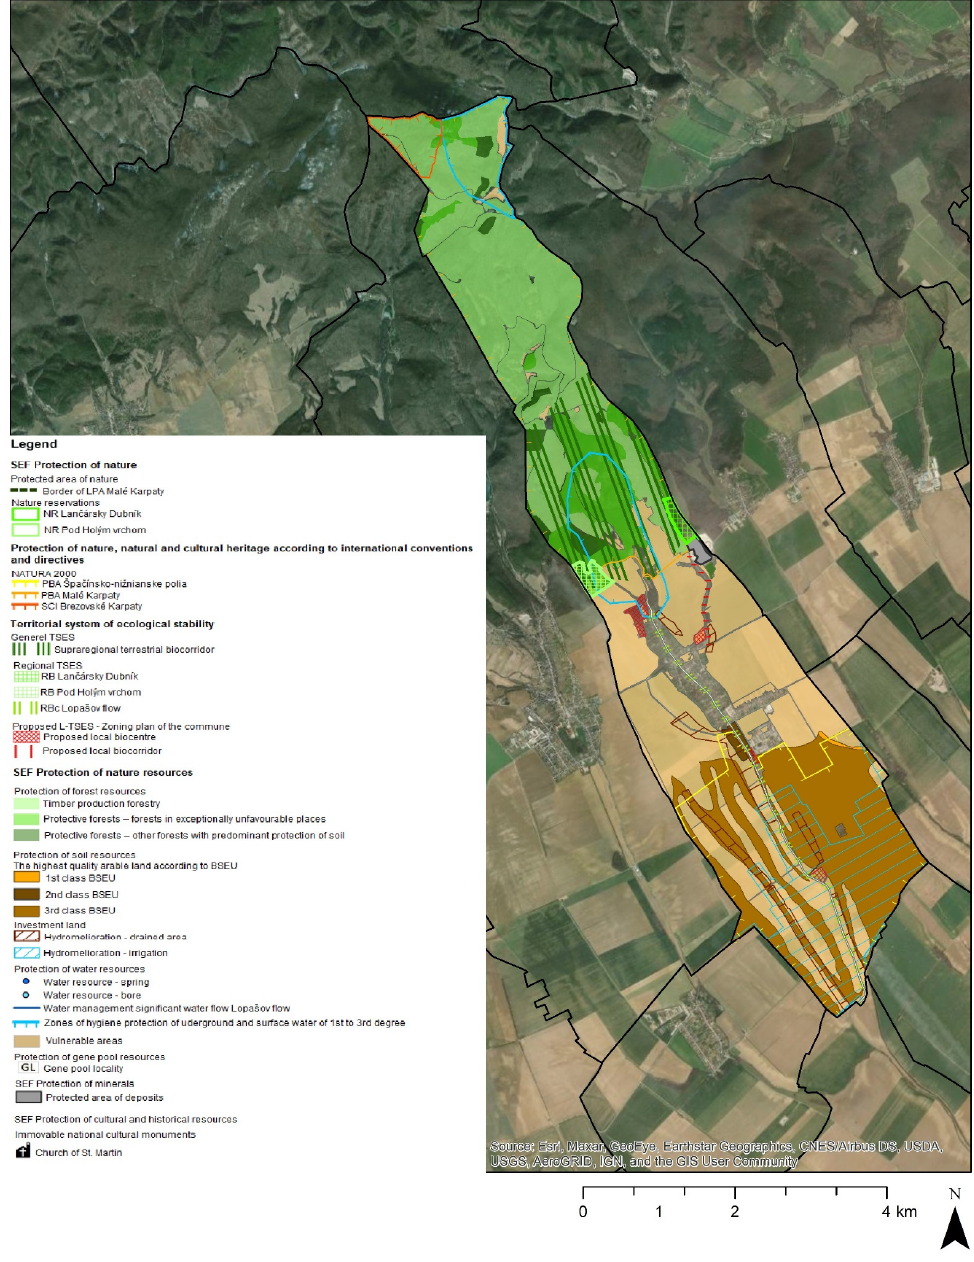
Figure 8. Positive socio-economic factors of Doln ý Lopašov community. Author: Moyzeov á , M. Technical processing: Raniak, A. (in Špulerov á , et al.,